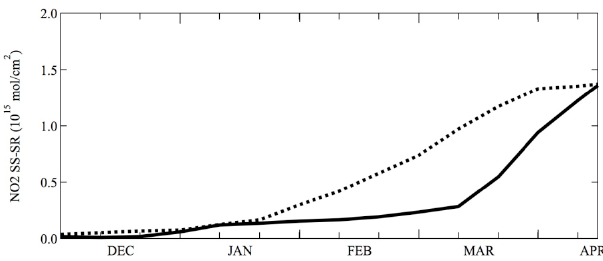
Fig. 4. Amplitude of the NO 2 diurnal cycle inside (solid line) and outside (dotted line) the vortex.